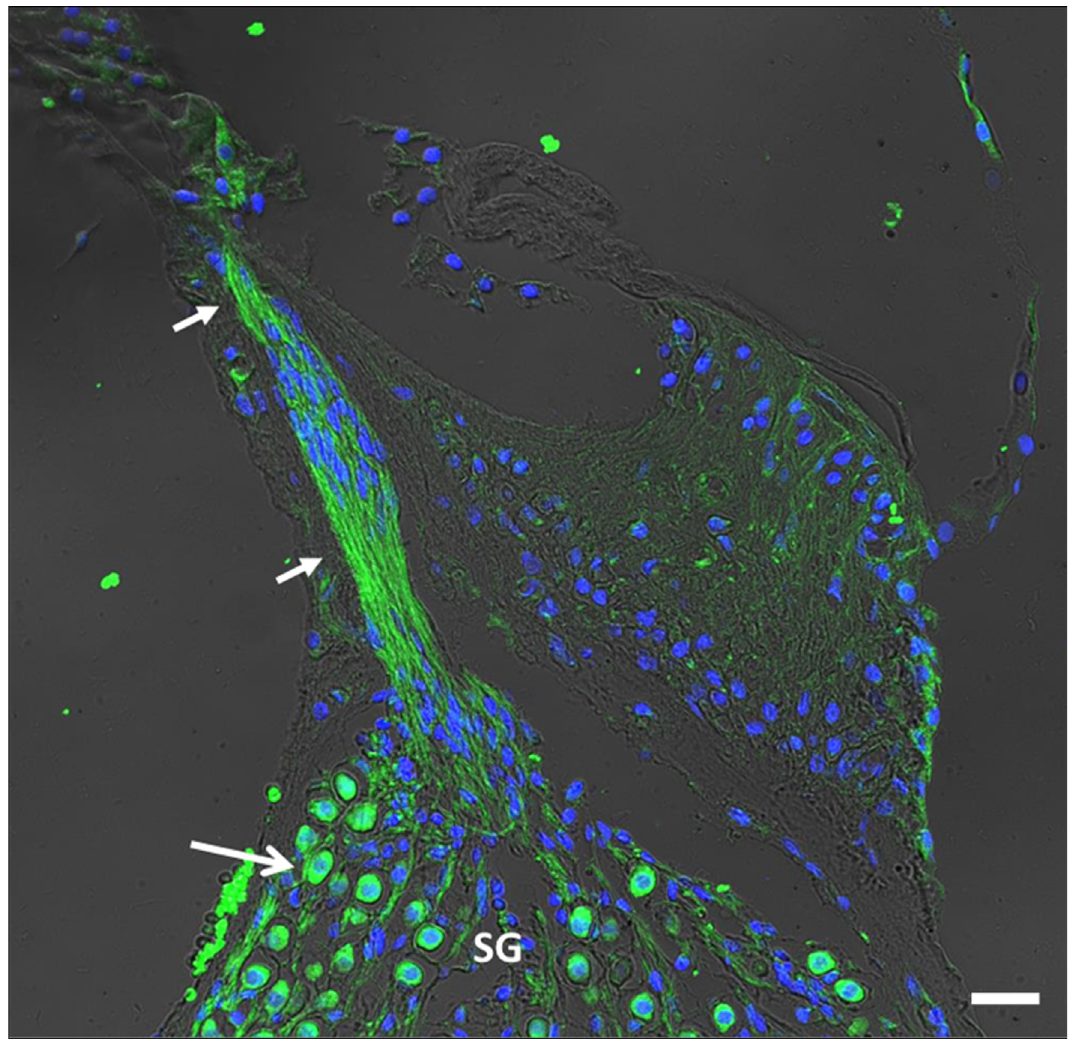
Fig 4. Close view of CB 2 immunolabeling of nerve fibers and spiral ganglion. Neurites are intensely labeled (short arrows), as well as the soma (long arrow) of the spiral ganglion (SG) neurons (Scale bar = 30 μ